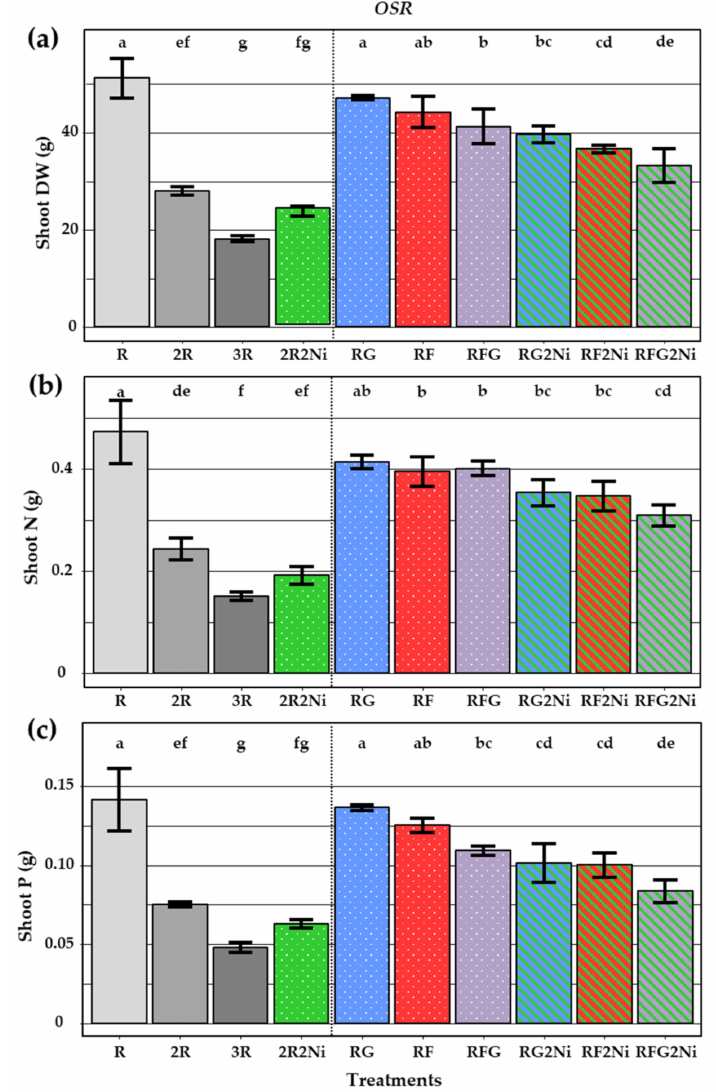
Figure 4. Dry weight (DW) ( a ), N ( b ) and P ( c ) in OSR shoots. R: OSR ( Brassica napus L. cv Avatar), F: Faba bean ( Vicia faba L. cv Fanfare), G: Grass pea ( Lathyrus sativus L. cv Merkur) and Ni: Niger ( Guizotia abyssinica (L.f.) Cass.). Means of four replicates. Error bars are SDs. For all the Kruskal– Wallis ( a , c ) and one-way ANOVA ( b ) tests p < 0.001, the letters a, b, c, d, e, and f represent the groups of significantly different modalities according to the Conover post hoc test ( a , c ) or the Tukey HSD test ( b